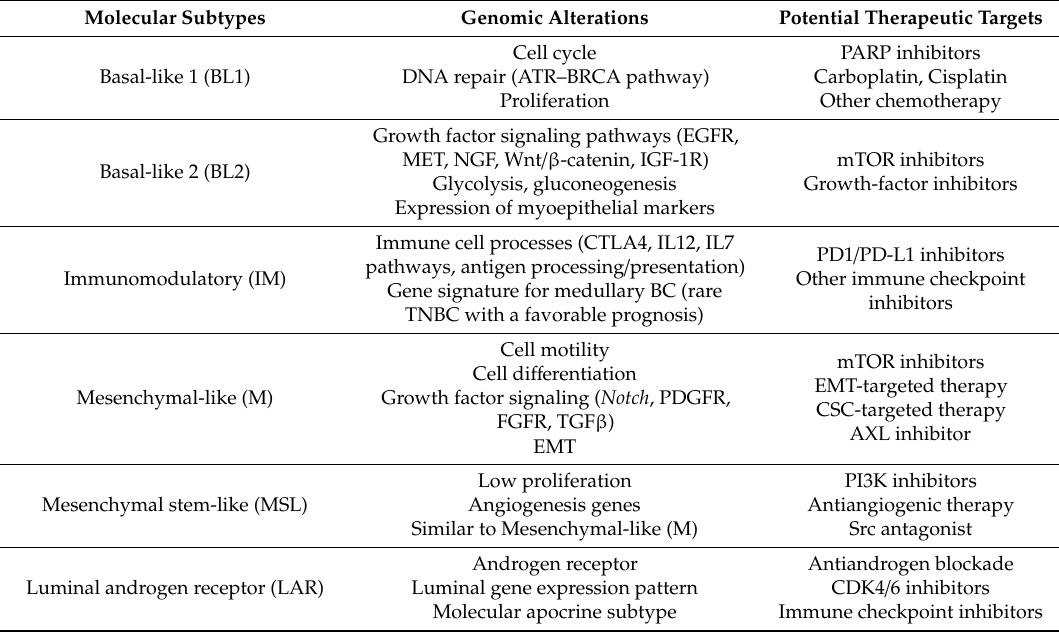
Table 1. Triple negative breast cancer (TNBC) molecular subtype and potential targets for